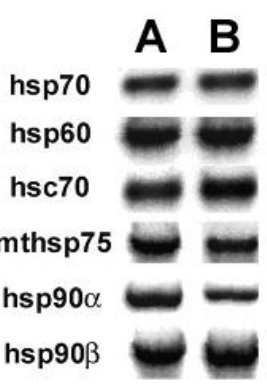
FIGURE 3. PCR analysis of expression of genes coding for stress response proteins by control (A) and midregion PTHrP-treated (B) MDA- MB231